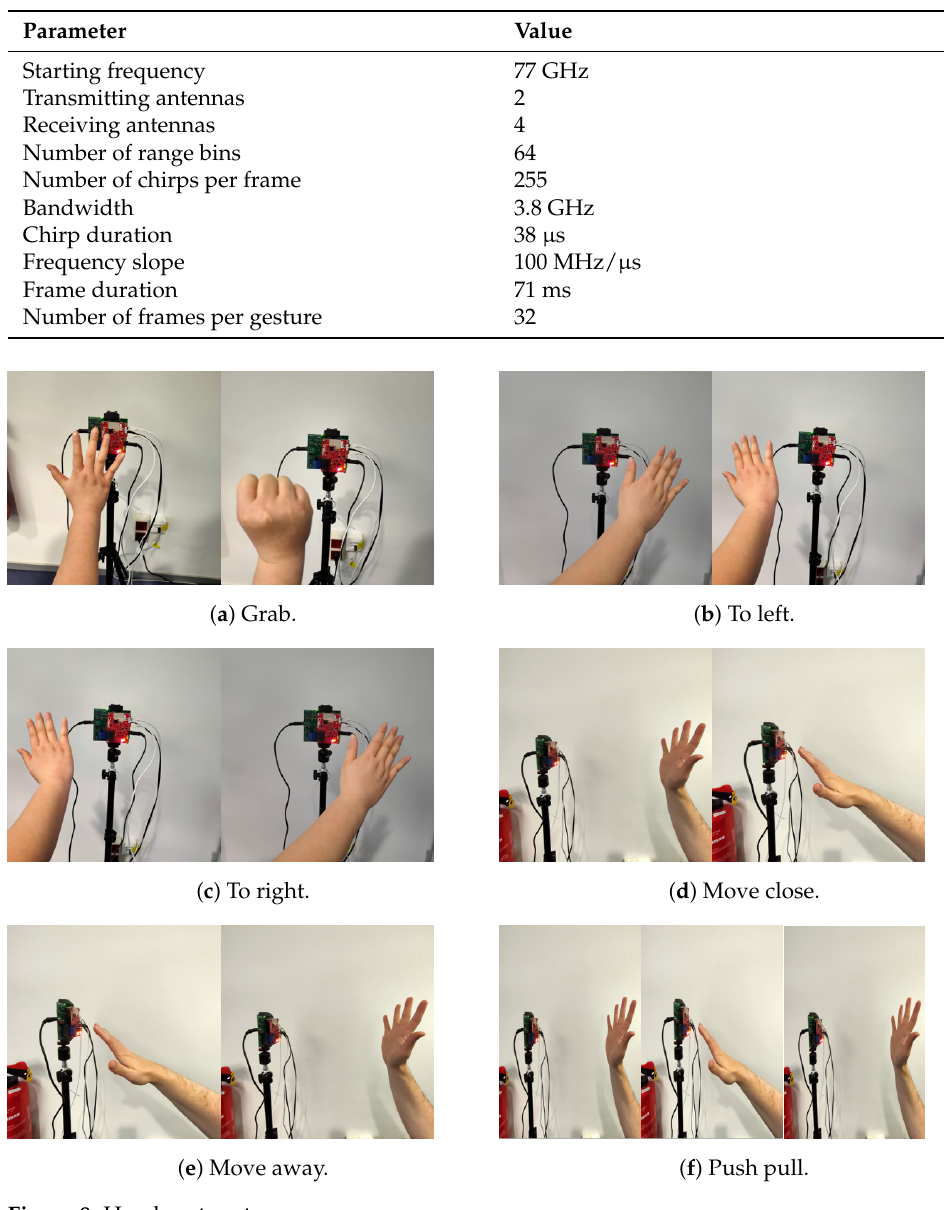
Figure 8. Hand gesture